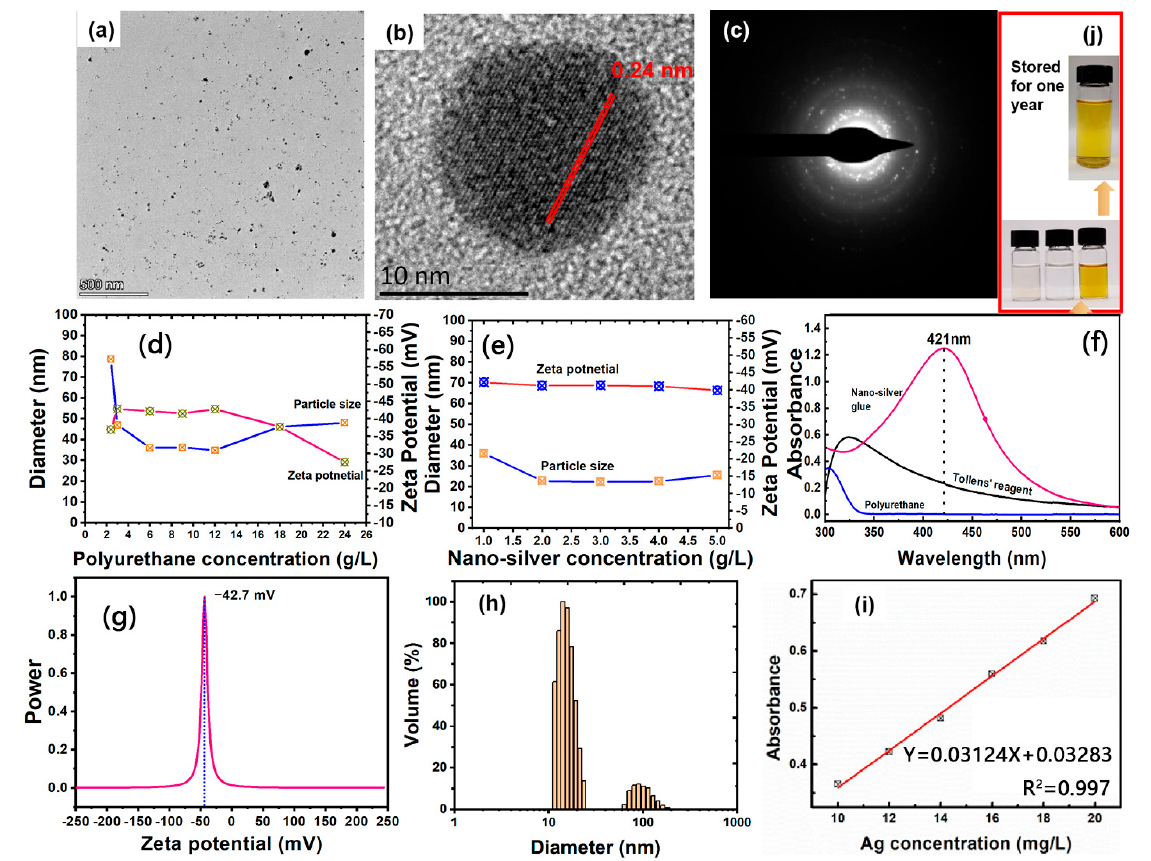
Figure 1. ( a , b ) TEM images, ( c ) Selected area of electron diffraction pattern, ( f ) UV–vis spectra, ( g ) Zeta potential, ( h ) Particle size distribution of nanosilver glue. ( d ) Diameter of nanosilver as a function of polyurethane concentration. ( e ) Diameter of nanosilver as a function of silver concentration (the mass ratio of silver and polyurethane is set as a constant: 1:9). ( i ) Linear fitting curve of the silver concentration and corresponding UV–vis absorbance (434 nm). ( j ) Photos of the solutions of (lower left) polyurethane, (lower middle) Tollens’ reagent, (lower right) freshly synthesized nanosil- ver glue (4 g/L of mother solution, diluted to 10 mg/L), and (top) that stored for one year (4 g/L of mother solution, diluted to 10 mg/ L).